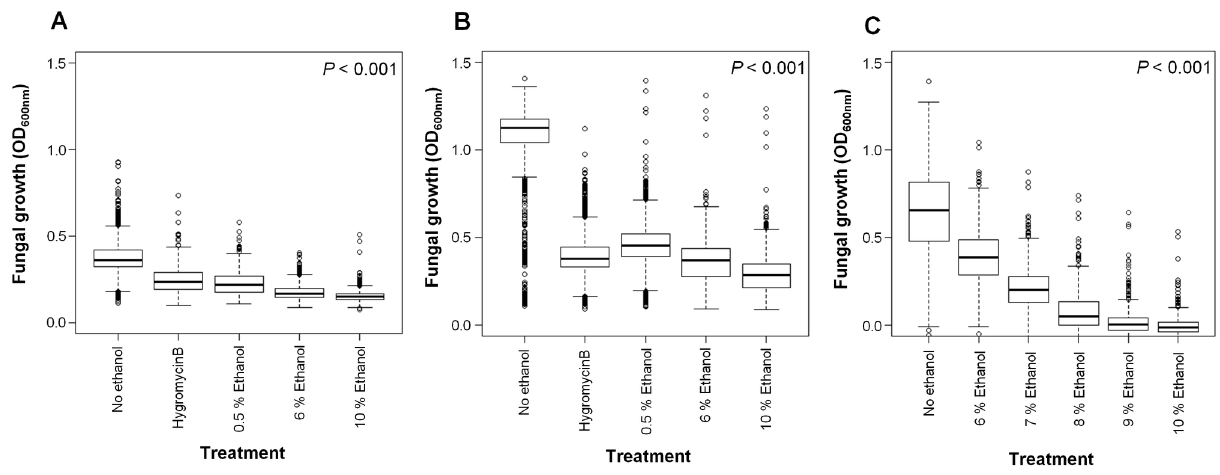
Figure 1. Primary and second – tier screening of putative Fusarium oxysporum strain 11C transformants. Box and Whisker plot depicting the distribution of putative Fusarium oxysporum strain 11C transformants ( n =1,563) screened for altered ethanol tolerance during primary screening at 48 hours ( A ) and 96 hours ( B ) and transformants ( n =402) screened for altered ethanol tolerance during secondary screening ( C ). Fungi were grown at 25°C in minimal medium [37] with five different treatments; no ethanol control; hygromycinB 60 µg ml -1 control; 0.5% (vv -1 ) ethanol; 6% (vv -1 ) ethanol; 10% (vv -1 ) ethanol) (Primary-tier) ( A , B ) or six treatments; no alcohol control; 6% (vv -1 ) ethanol; 7% (vv -1 ) ethanol; 8% (vv -1 ) ethanol; 9% (vv -1 ) ethanol; 10% (vv -1 ) ethanol (Second- tier) ( C ). Fungal growth (OD ) was measured after 96 hours using a spectrophotometer (Safire 2 , Tecan, Austria). 600nm doi: